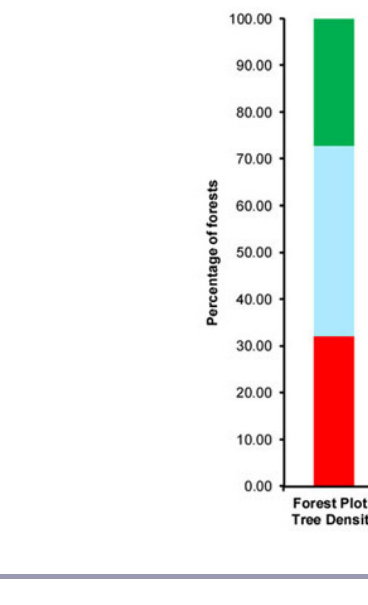
Fig. 1. Assessments of changes in forest vegetation density based on indicators derived from forest plots and assessments by forest users and professional